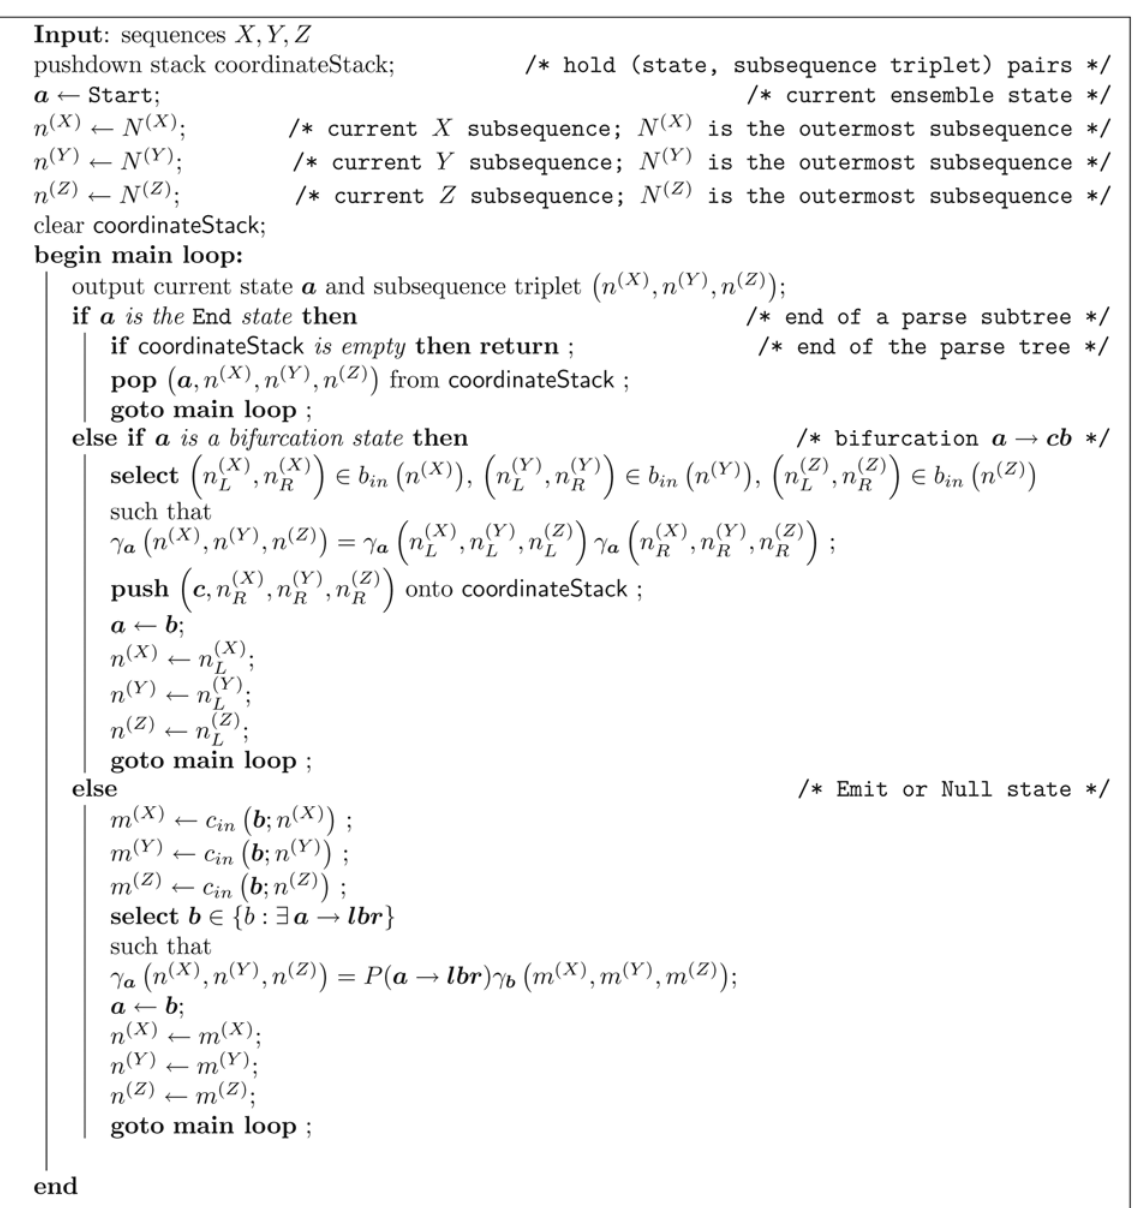
Figure 5. Algorithm 5. The constrained CYK traceback algorithm for three sequences X , Y , Z .